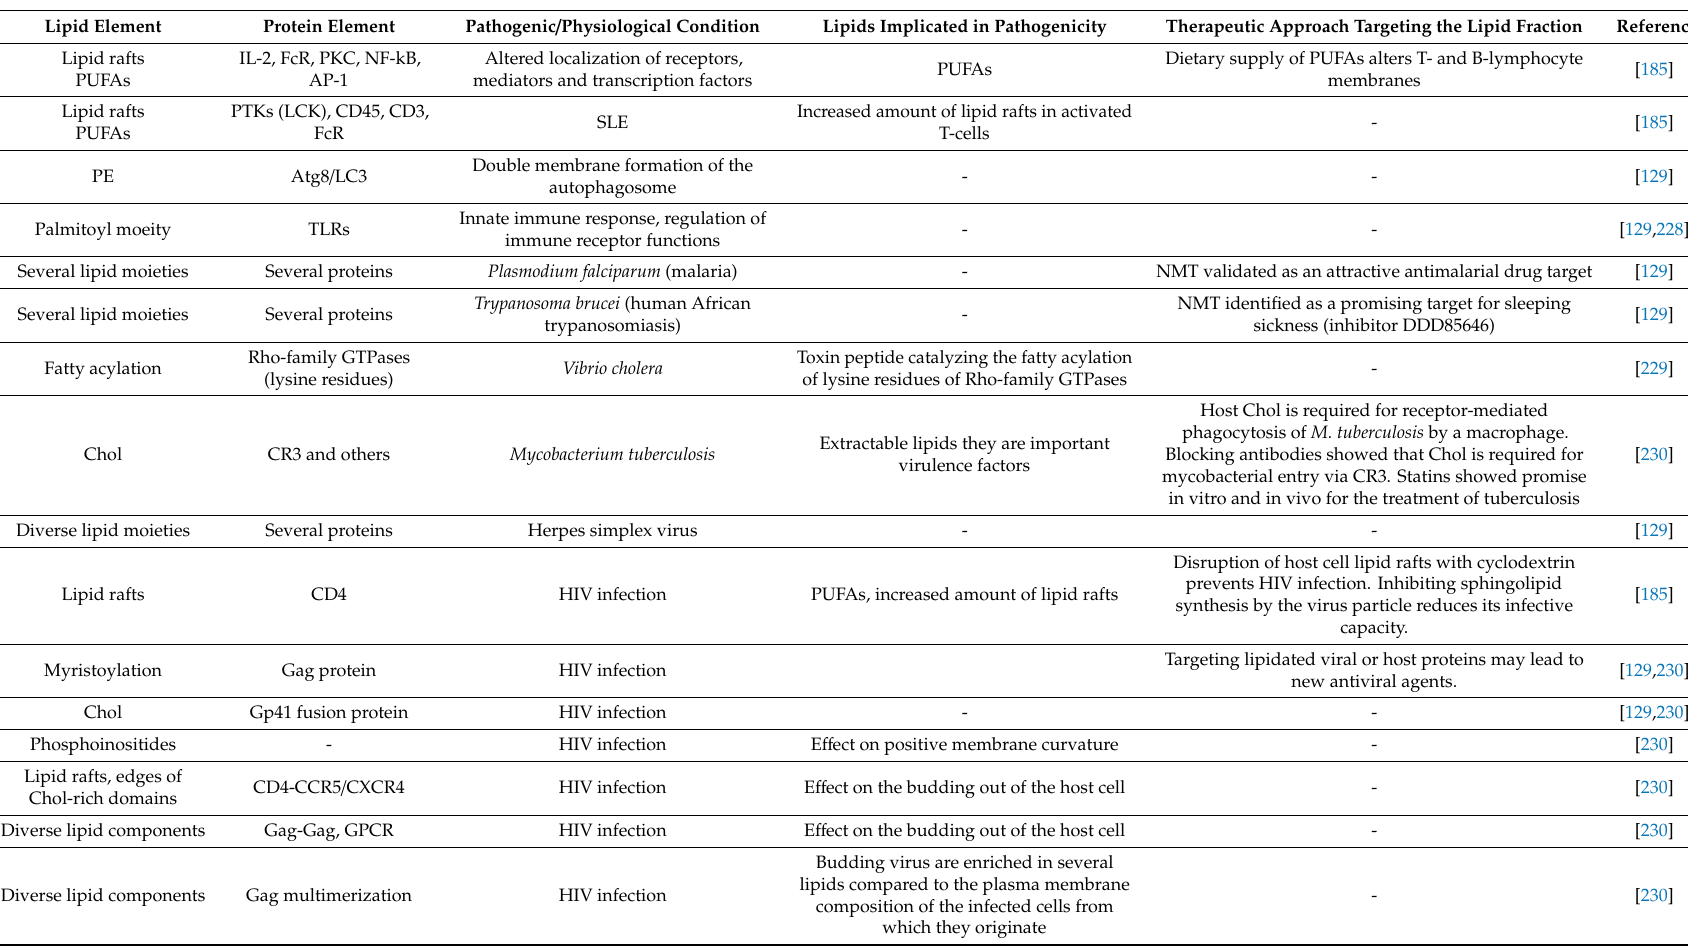
Table 1. Lipid structures involved in various pathological conditions a ff ecting the immune